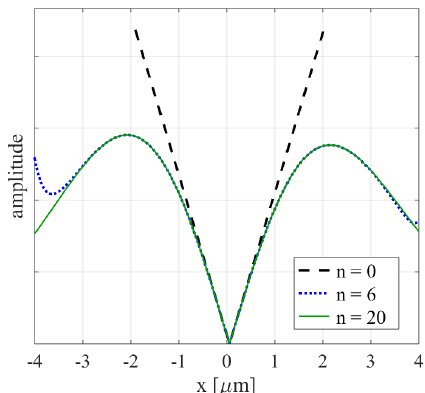
Figure 3. The amplitude distribution of the off-axis vortex beam ( m = 1, x c = 0.02 mm) for the system shown in Figure 2b in case of n = 0, n = 6 and n =